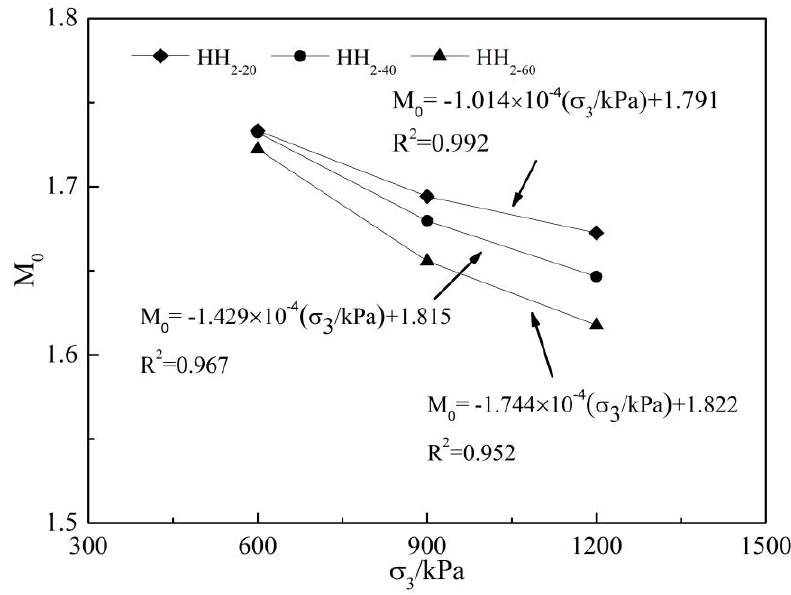
σ Figure 6. Relationship between stress ratio M 0 and confining pressure σ 3 at phase change. M Figure 6. Relationship between stress ratio 0 and confining pressure 3 at phase change. Figure 7 shows the relationship between nonlinear strength index ϕ 0 , ∆ ϕ and d max . It can be seen from Figure 7 that the nonlinear strength index ϕ 0 and ∆ ϕ both increases with the increase of the maximum particle size d max . Among them, the value ϕ 0 and ∆ ϕ of HH 2-40 increases by 1.449 ◦ and 1.818 ◦ compared with the corresponding value of HH 2-20 , while the value of HH 2-60 increases by 0.885 ◦ and 1.470 ◦ compared with the corresponding value of HH 2-40 . When the particles are larger, the biting force between soil particles is better, and the correlation with d max is weaker.